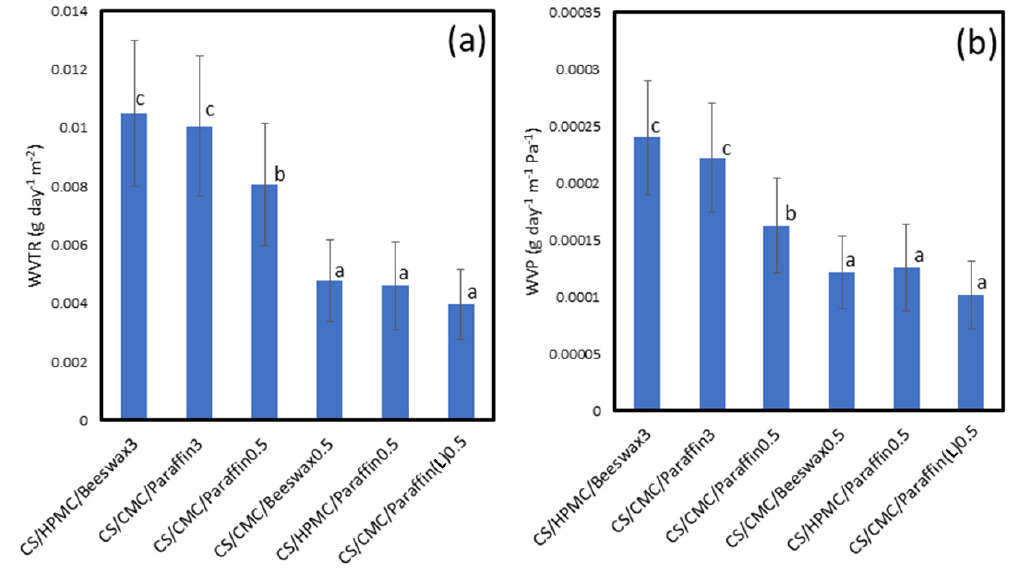
Figure 5. Water ‐ resistance properties of coating materials: ( a ) water vapor transmission rate (WVTR) and ( b ) water vapor permeability (WVP) ( n = 5). Means with different lowercase superscript letters were significantly different ( p < 0.05).